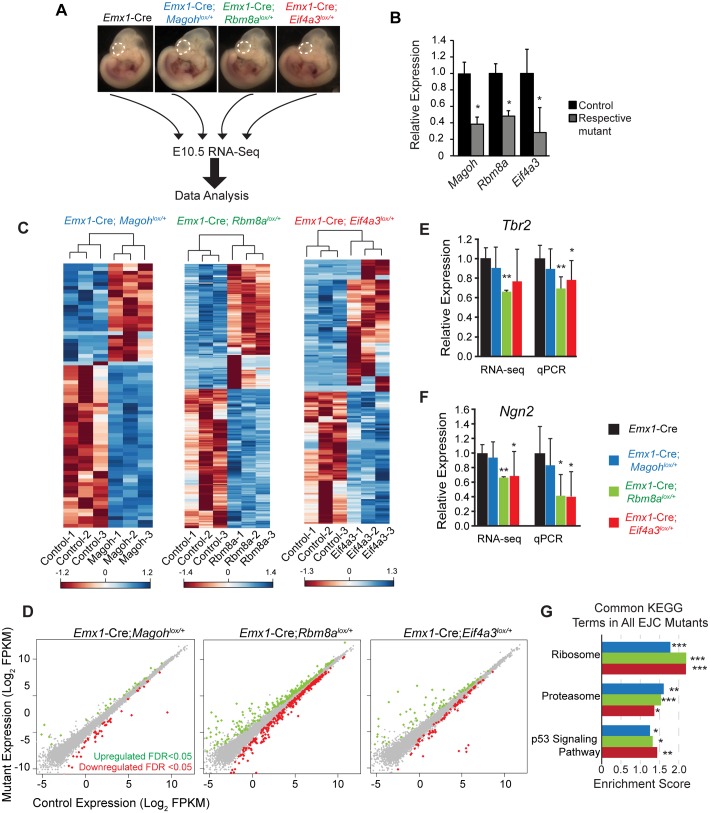
Transcriptome analyses of E10.5 Magoh, Rbm8a, and Eif4a3 haploinsufficient cortices reveal common downstream pathways.(A) Diagrammatic overview of RNA sequencing analysis of E10.5 neocortices from indicated genotypes. (B) qPCR showing expression of Magoh, Rbm8a, and Eif4a3 in their respective mutant E10.5 cortices. (C) Heatmaps showing z-score transformed normalized expression for all affected transcripts with an FDR corrected p-value, q< 0.05. Genes and samples were clustered using correlation distance with complete linkage. (D) Scatter plots of transcripts significantly upregulated (green dots) and downregulated (red dots) in E10.5 Emx1-Cre;Magohlox/+, Emx1-Cre;Rbm8alox/+, and Emx1-Cre;Eif4a3lox/+ cortices (q<0.05). (E, F) qRT-PCR validation at E11.5 compared to relative RNA-seq values of Tbr2 (E) and Ngn2 (F) in the indicated genotypes. For RNA-seq and qPCR, each control was normalized to 1.0 and compared to mutants. (G) Graph depicting common KEGG terms identified by GSEA analysis that were significant in all 3 EJC mutants, showing corresponding enrichment score. Student’s t test (B,E,F), Error bars, S.D. *, p<0.05, **, p<0.01, ***, p<0.001.